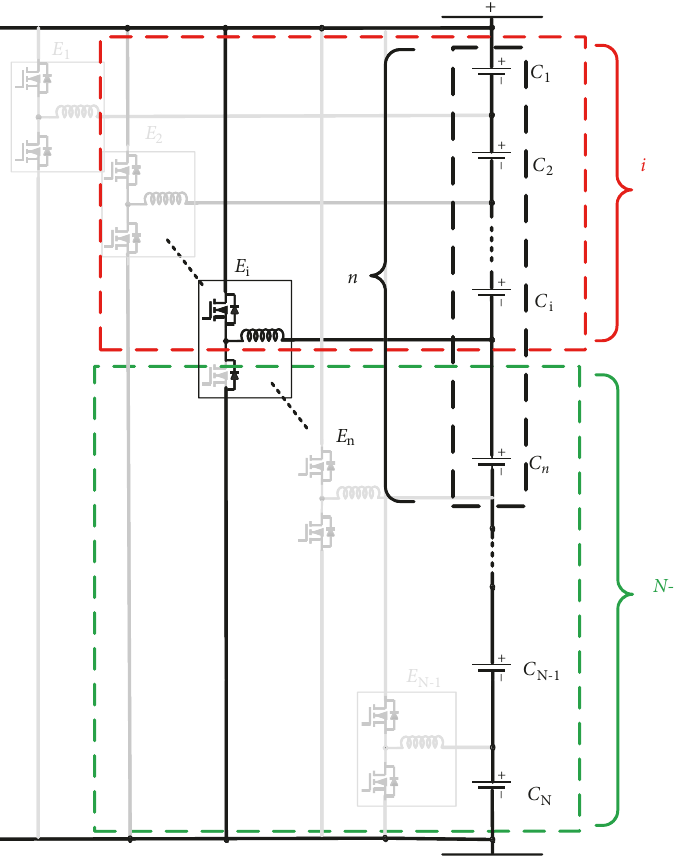
Figure 4: Energy transfer caused by the equalizer E i in the situation